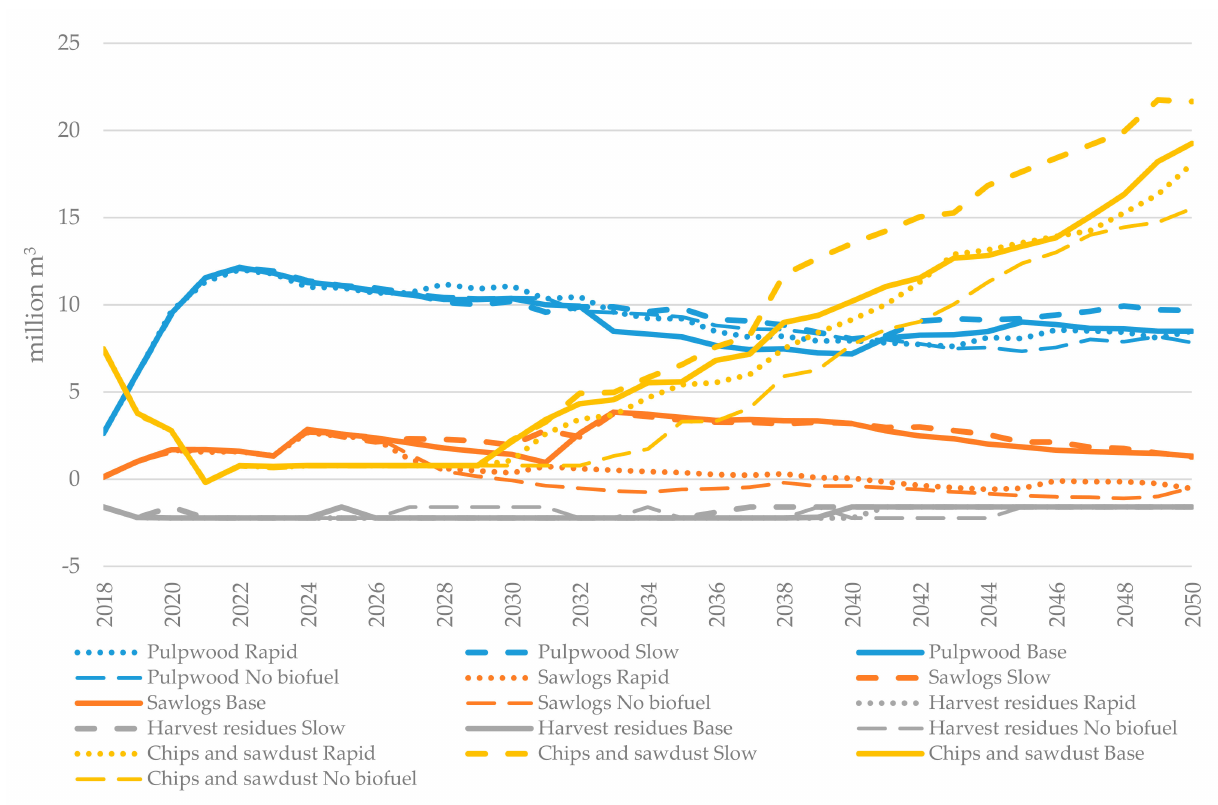
Figure 13. Modelled net import of wood biomass to the Nordic countries for the base, rapid and slow electrification